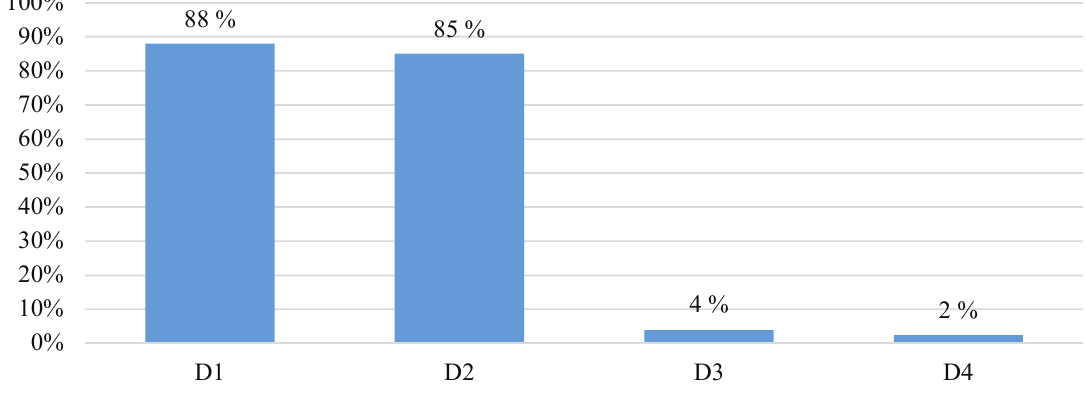
Fig. 7. The influence of the rector’s personality on the reputation of NUPh and raising the level of HEI brand awareness: D1 – the rector must be an outstanding scientist, D2 – the rector must be a good manager, D3 – the rector’s